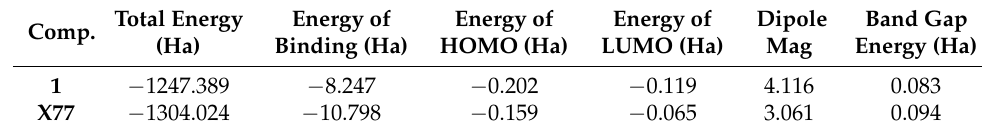
Table 4. The spatial distribution of molecular orbitals for jusan coumarin and X77 .